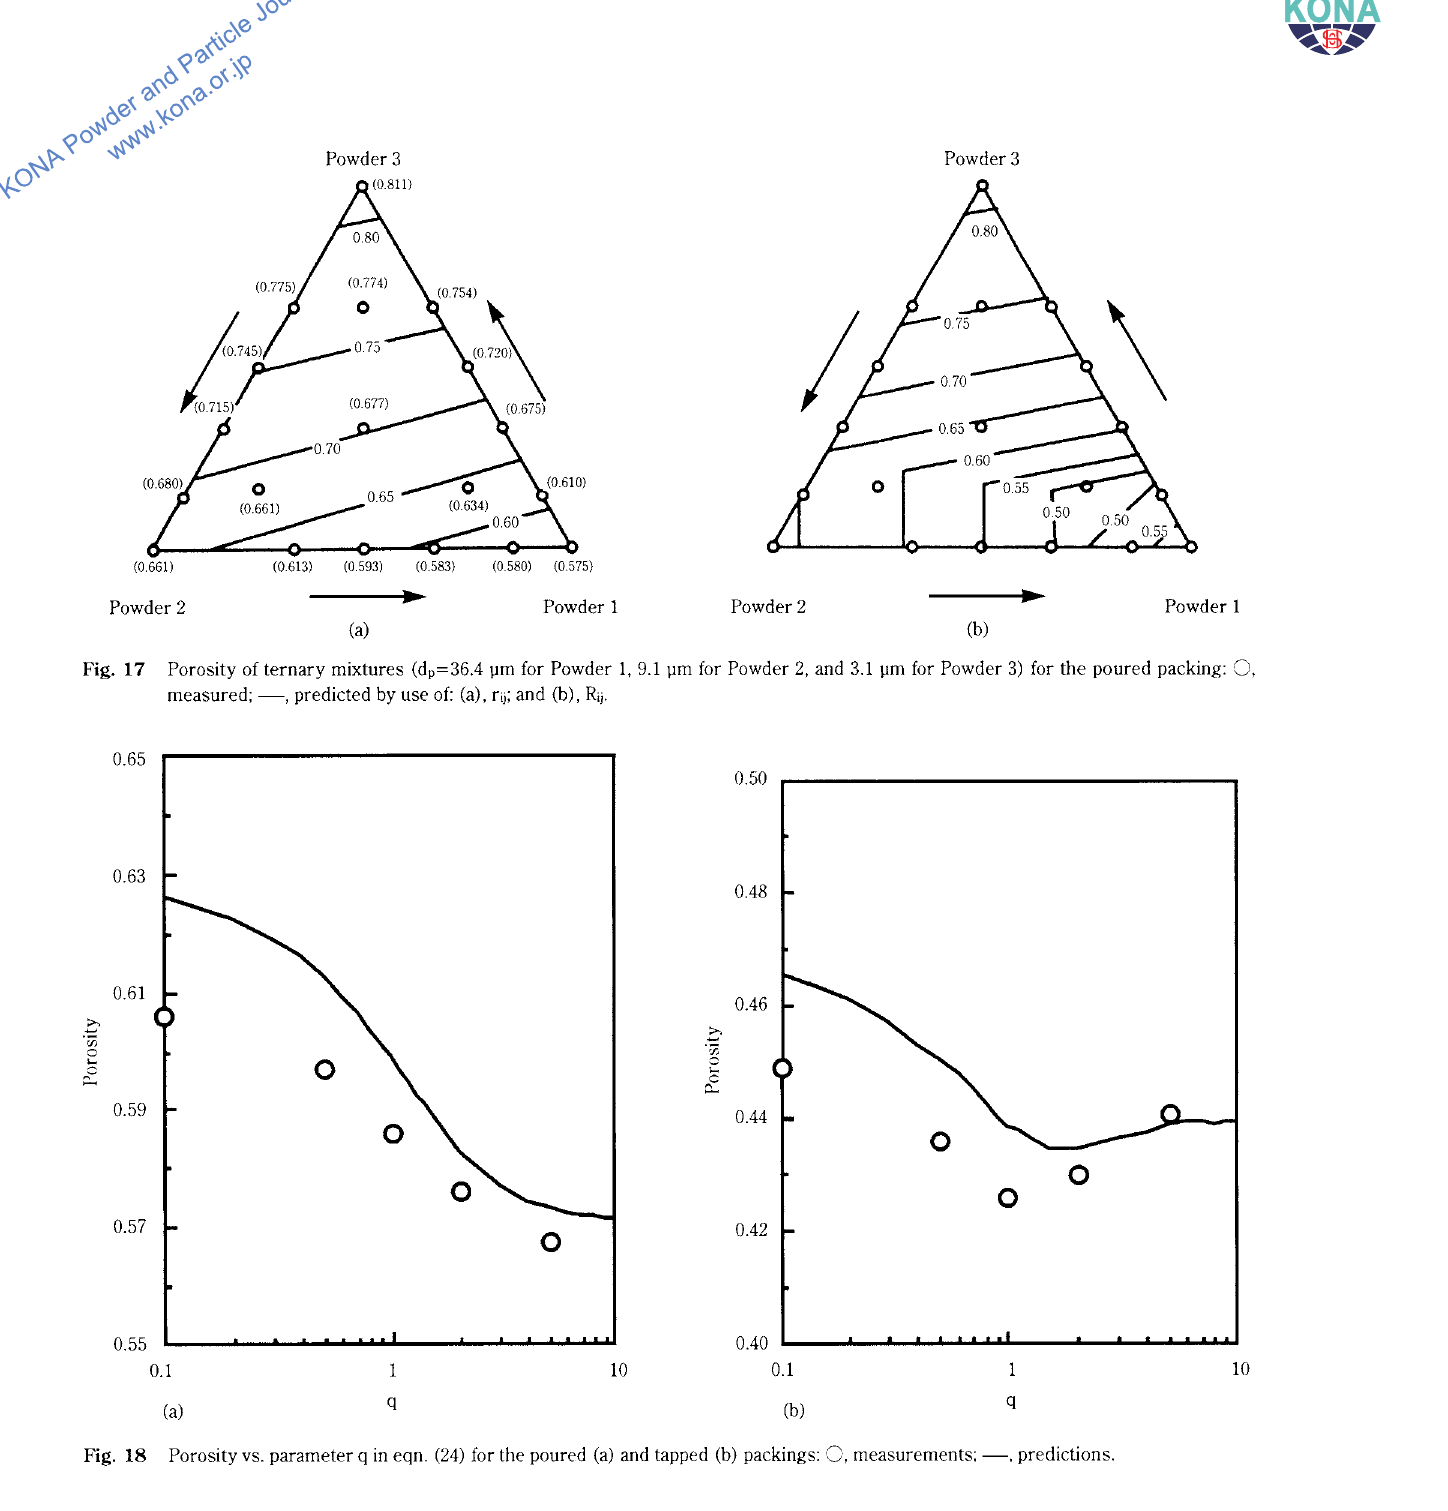
Fig. 18 Porosity vs. parameter q in eqn. (24) for the poured (a) and tapped (b) packings: C. measurements;-, predictions.